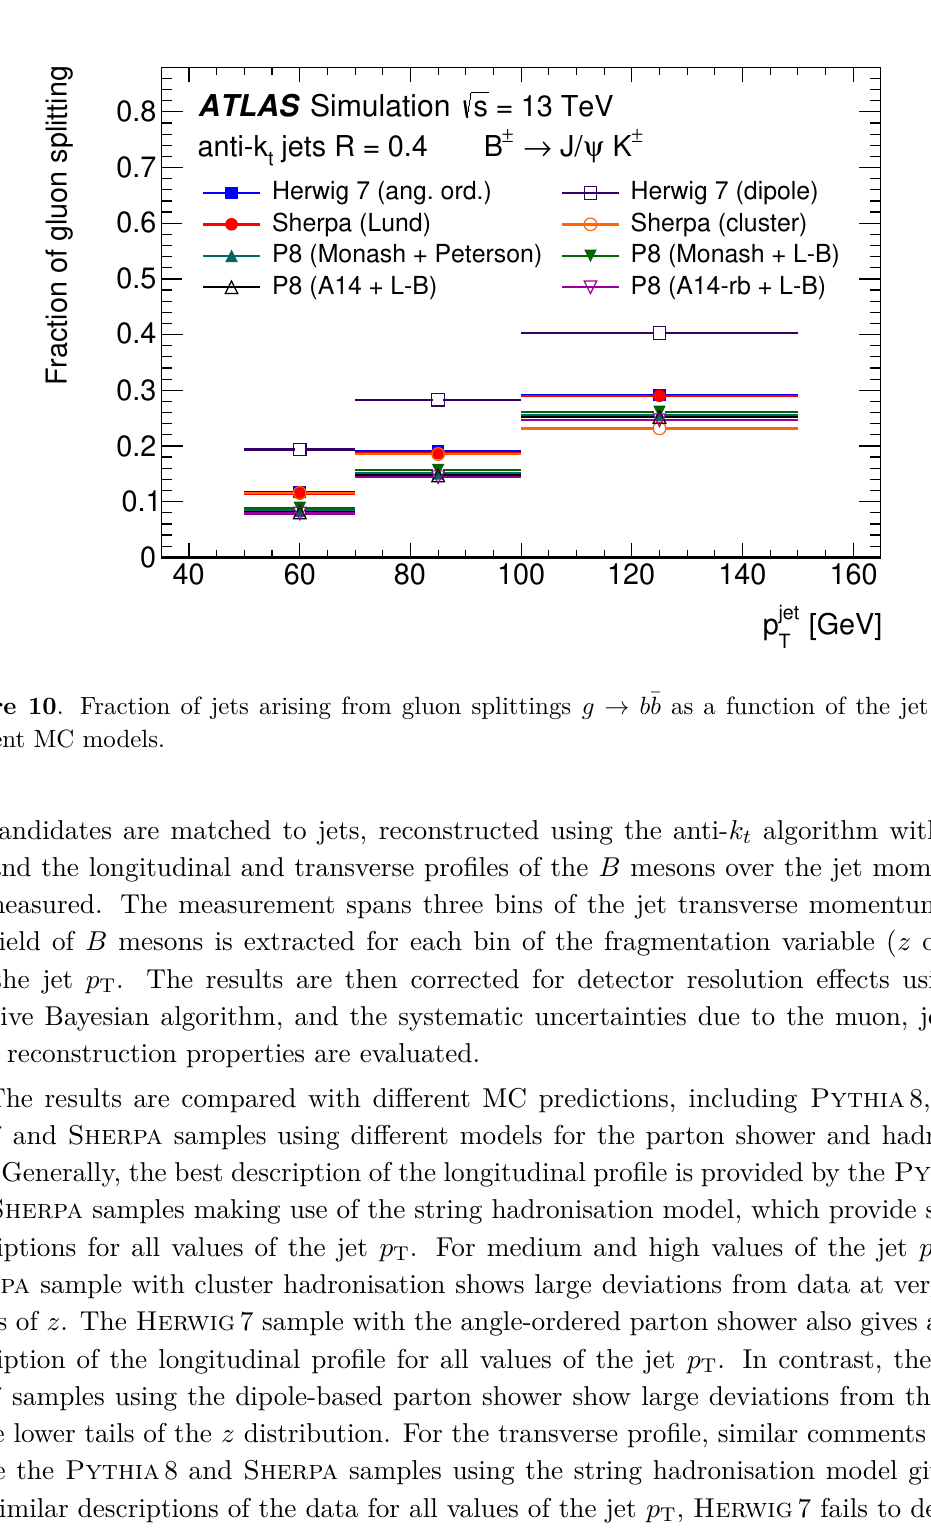
¯ b as a function of the jet p T for